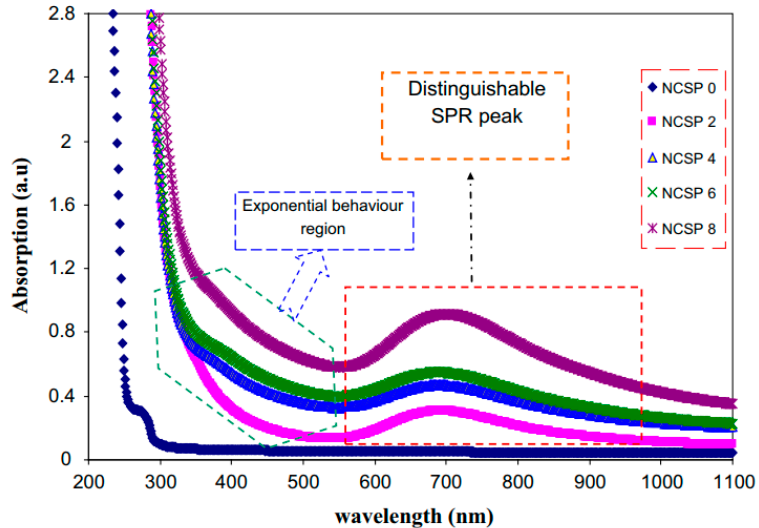
Figure 15. The pure PMMA and PMMA NCs absorption spectra of against wavelength. The films were specified as NCSP0, NCSP2, NCSP4, NCSP6 and NCSP8 for PMMA with 0 wt %, PMMA with 2 wt %, PMMA with 4 wt %, PMMA with 6 wt % and PMMA with 8 wt % of CuS, correspondingly [139].